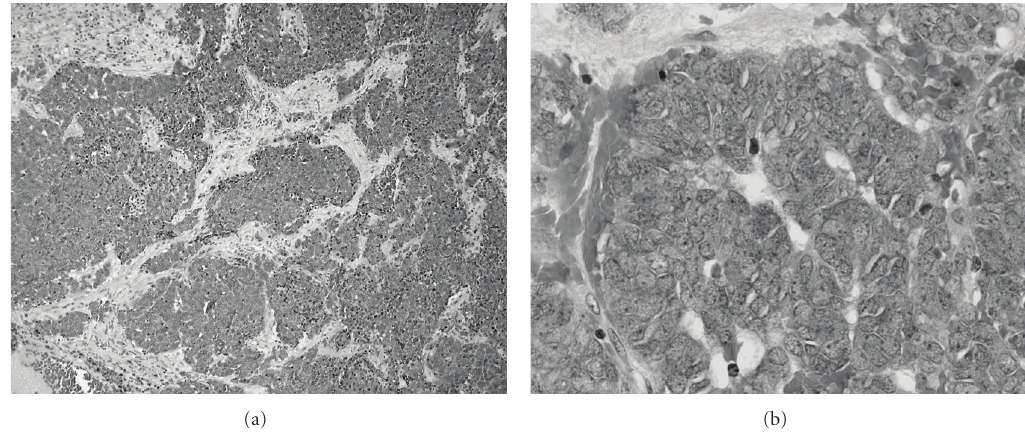
Figure 4: Histological findings of the HE-stained biopsy sections. (a) Low power view (magnification: x6). Cellular nodules are scatters within fibrous stroma. (b) High power view (magnification: x36). The tumor cells have oval nuclei with scant cytoplasms. Mitotic figures are common.